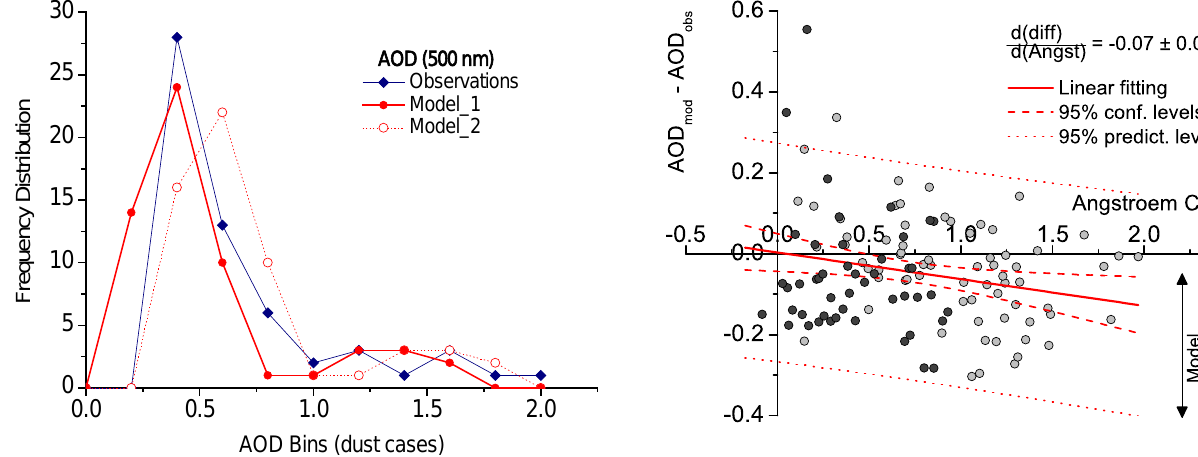
Fig. 5. The difference between modelled and observed AOD ver- sus the ˚Angstr¨om exponent. Darker points represent those data that meet the criteria of intense dust events (Sect. 2.3). The thick red line is the regression line, the dashed lines represent the standard error at the 95% confidence level, and the dotted lines correspond to the 95% prediction